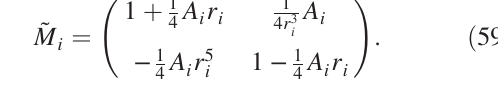
FIG. 4. Scaled longitudinal and transverse wakefields w l ¼ 4 correspond to the parameter set used in the beam loading study of Sec.